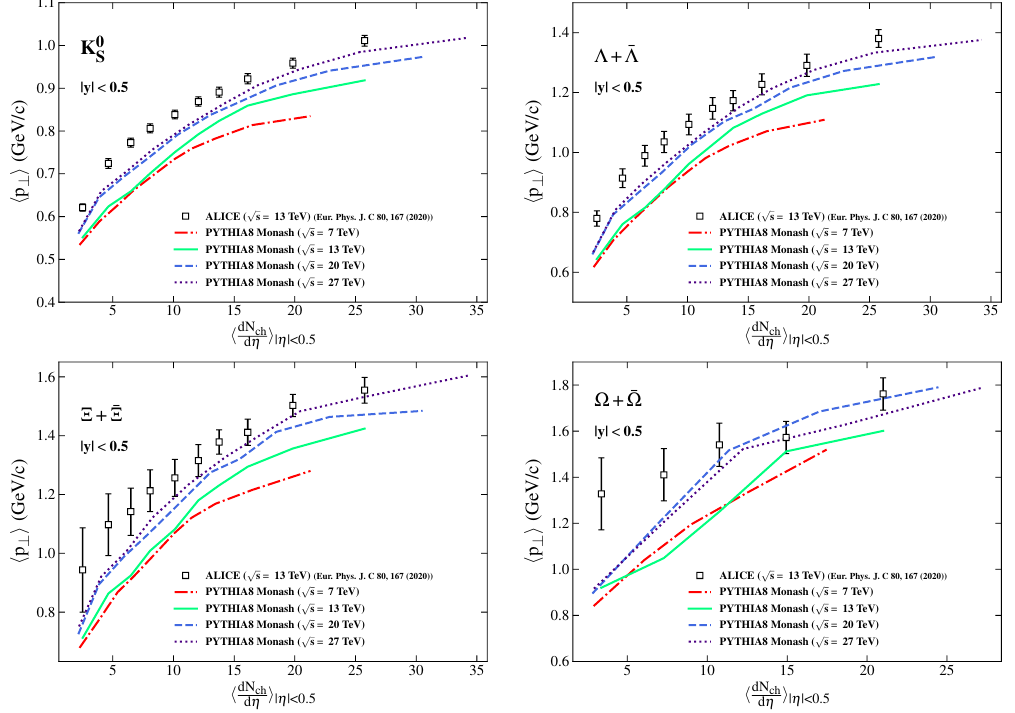
< 0.5 at √ s = 7 TeV, y | |